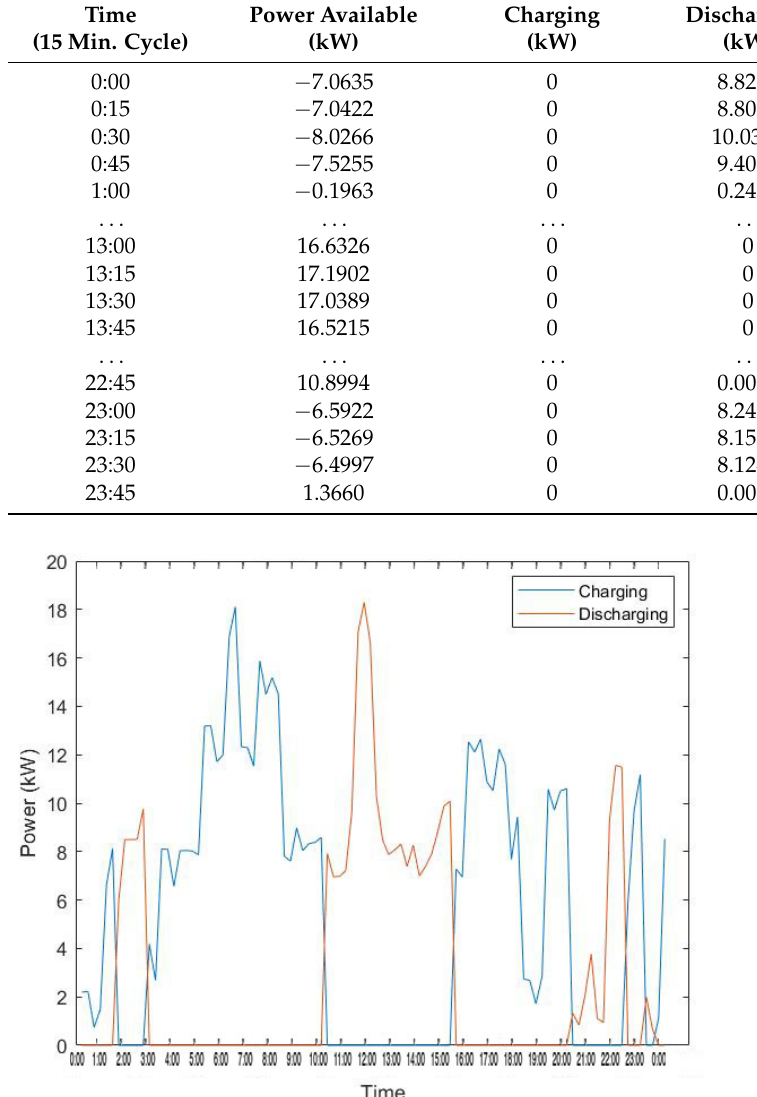
Figure 20. Charging and Discharging of Street Battery in CSPVND.